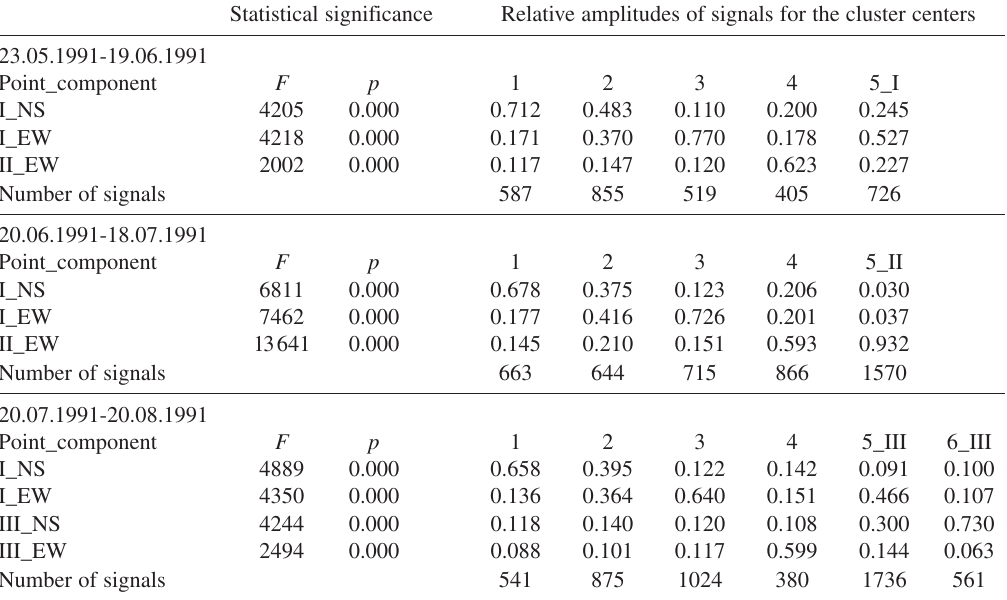
Table I. The result of cluster analysis of electrotelluric signals with steep fronts (see the text). Numbers of points are designated by the Roman numbers, EW and NS specify orientation of measuring lines. Statistical significance Relative amplitudes of signals for the cluster